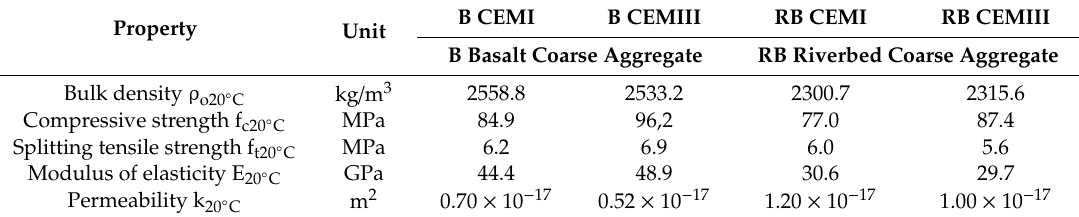
Table 5. Initial properties and parameters of the test